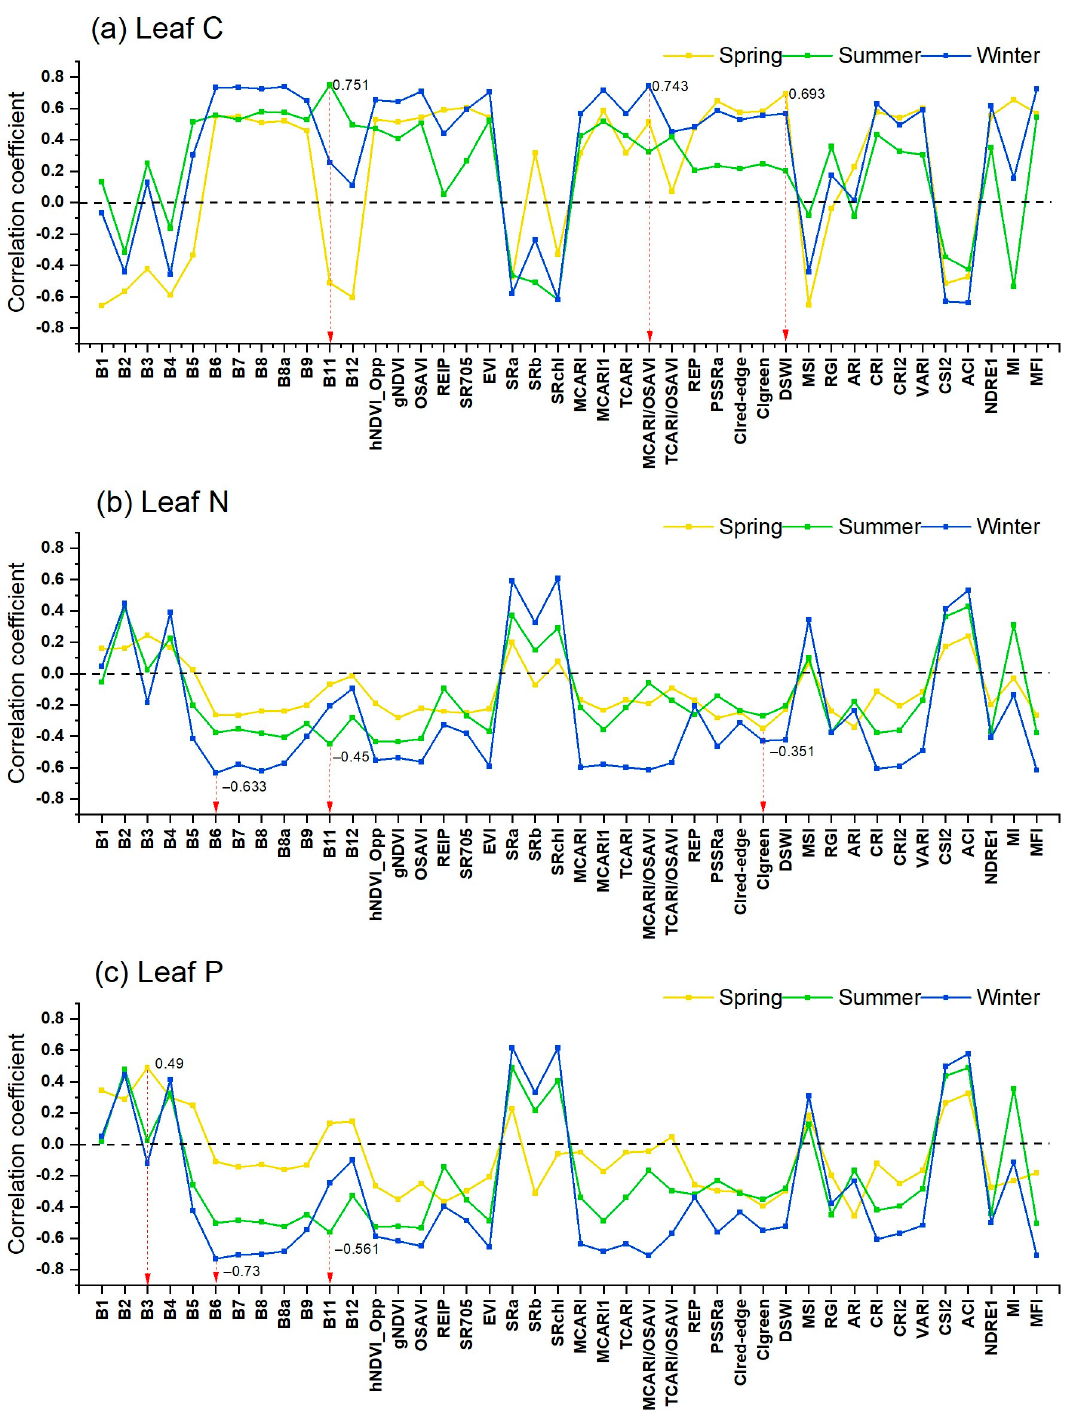
Figure 3. Correlations of leaf C ( a ), N ( b ), and P ( c ) against spectral features (12 spectral bands + 30 VIs) of Sentinel-2 images in spring, summer, and winter. The red arrow indicates the feature with the highest correlation in each season.